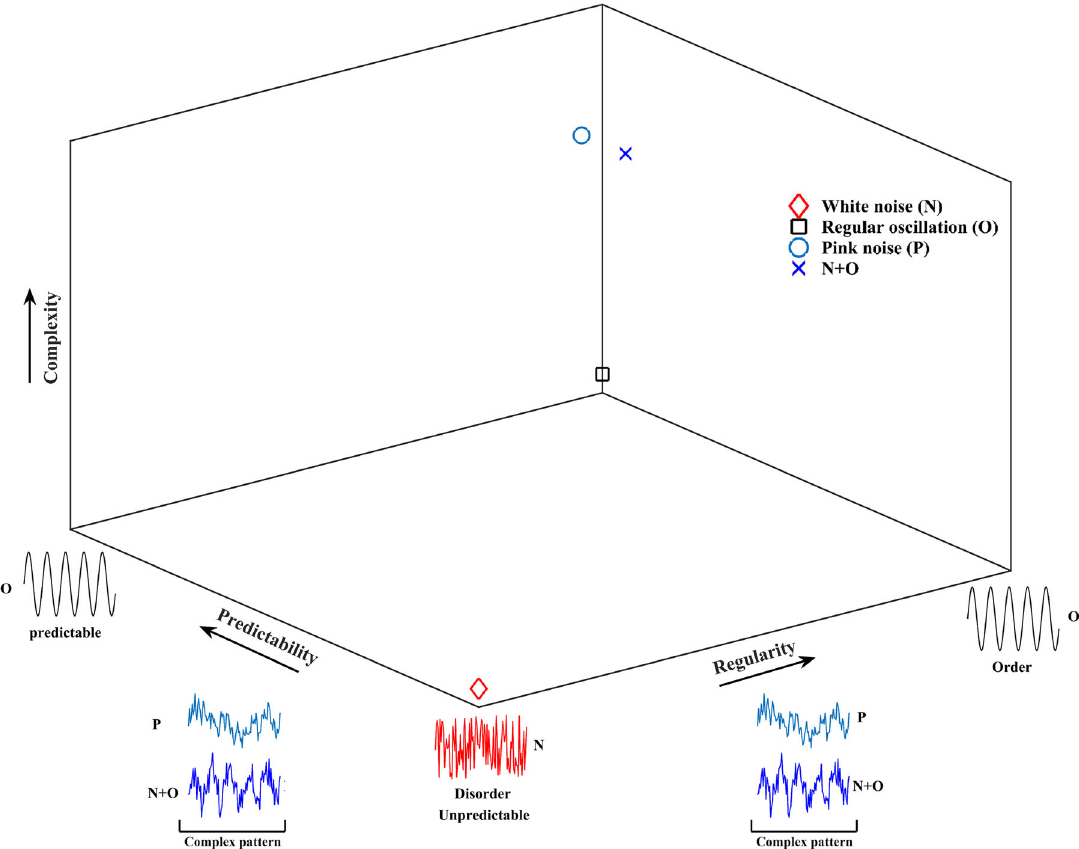
Fig. 1 The 3-D representation of regularity, predictability, and complexity. The extreme end of the regularity and predictability represents disorder and order and unpredictable and predictable. The random signal, such as white noise (N), represents the highest disorder and unpredictability. In contrast, regular oscillation such as sine wave (O) represents the highest order and predictability, while random signal and regular oscillation exhibited the least complexity. The combination of random signal with the regular oscillation (N + O) may fall anywhere in the intermediate zone of regularity and predictability, similar to the pink noise (P), representing the increased